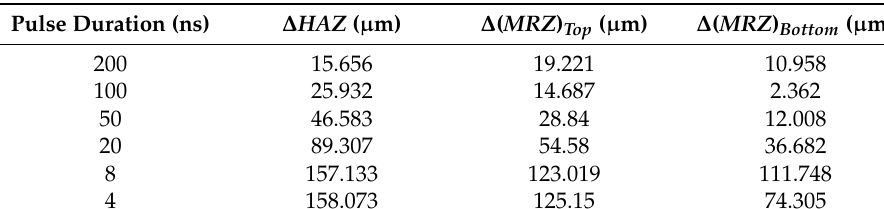
Table 2. ∆ HAZ , ∆ MRZ Top , and ∆ MRZ Bottom .